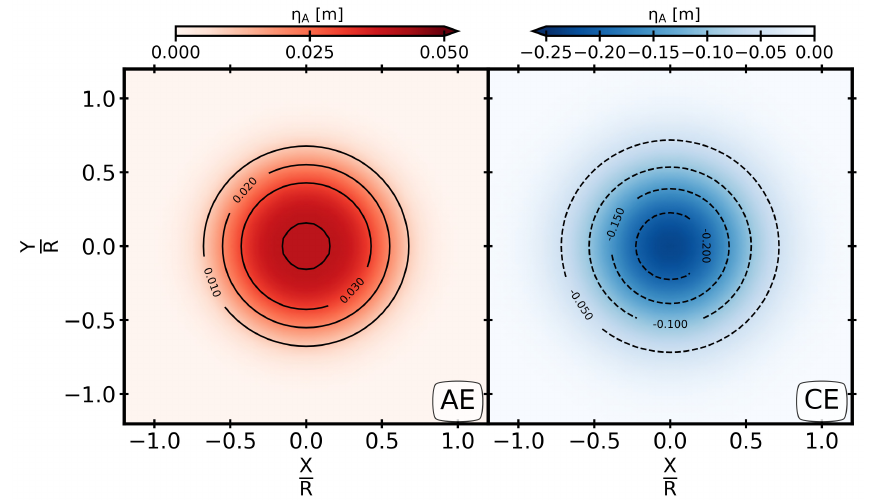
Figure 13. Sea level anomaly for the AE and CE of